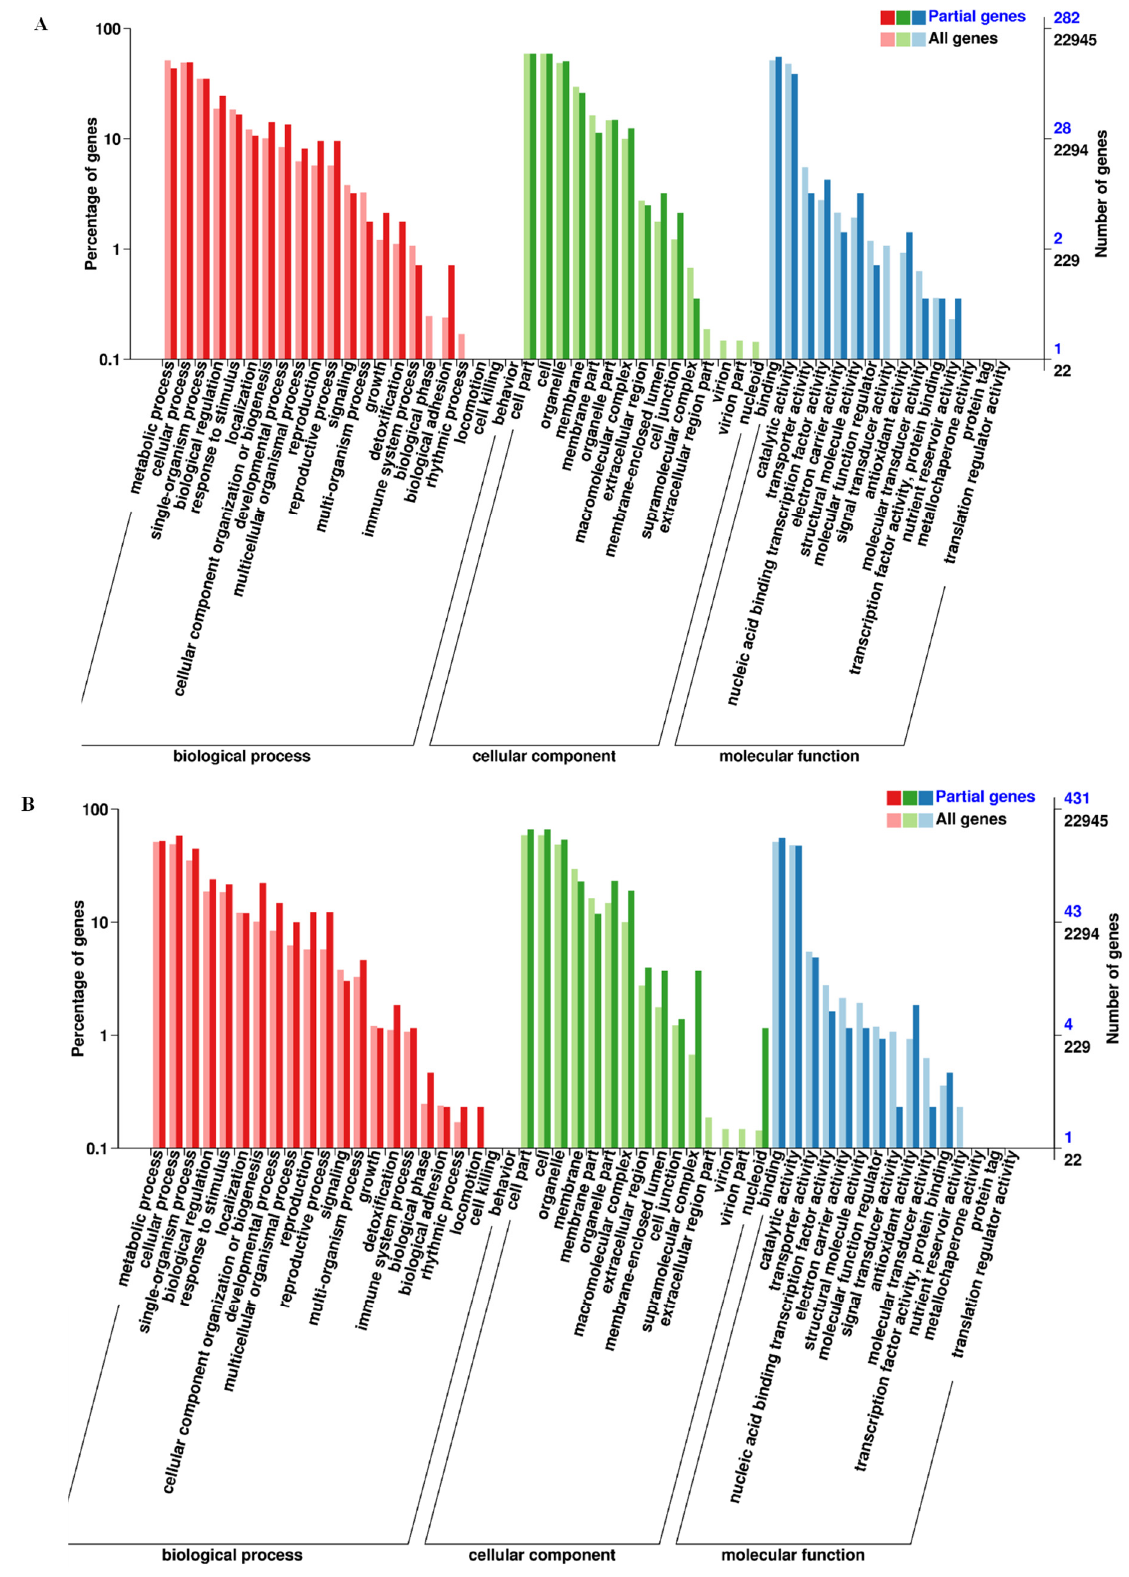
Figure 3. Functional classification of LK-tolerance-related DEGs identified in three barley accessions after 48 h ( A ) and 15 d ( B ) of LK stress by Gene Ontology (GO) categorization. The bold color indicates the representation in the whole genome; the light color indicates representation in the DEGs.